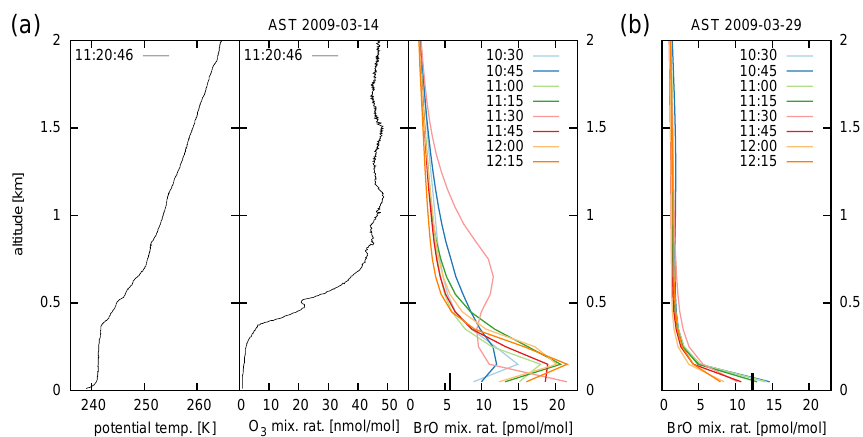
Fig. 20. (a) Profiles of potential temperature, O 3 , and BrO mixing ratio at Barrow on 14 March 2009. (b) BrO profile on 29 March 2009. The marks at the bottom of the BrO profiles denote the values measured by LP-DOAS. Potential temperature and O 3 are measured by ozonesonde (courtesy of NOAA Earth System Research Laboratory). BrO profiles are retrieved from MAX-DOAS measurements (Frieß et al., 2011).